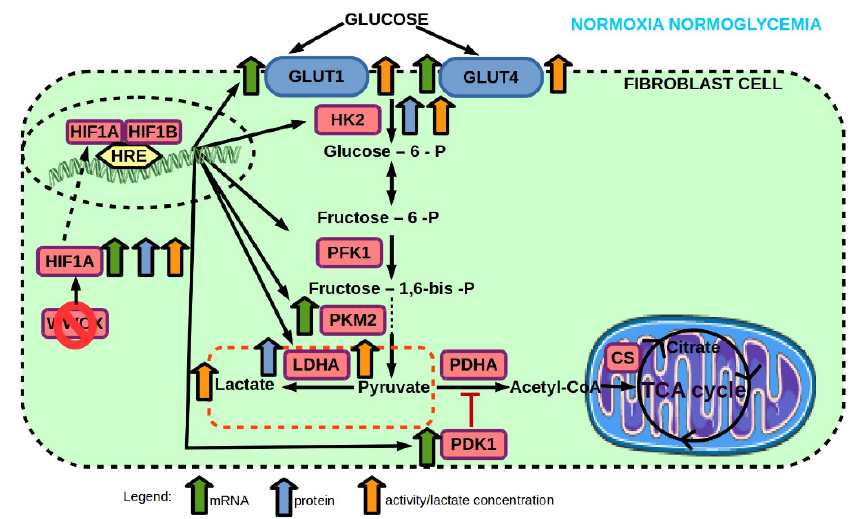
Figure 9. Effect of WWOX KO on mRNA and protein expression, and enzyme activity of genes involved in glucose transport and glycolysis pathway of 1BR.3.N fibroblast cell line in normoxia normoglycemia condition. Based on free images from Servier Medical Art; CC BY 3.0.